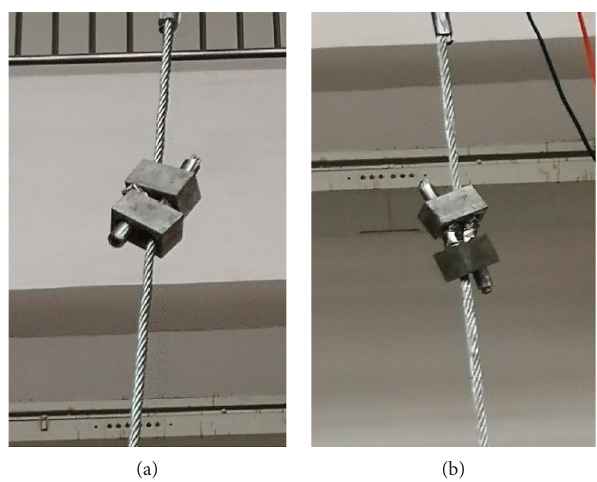
Figure 16: Tube-crushing dissipators after dynamic impact. (a) Tubes fully collapsed. (b) Tubes not fully collapsed.